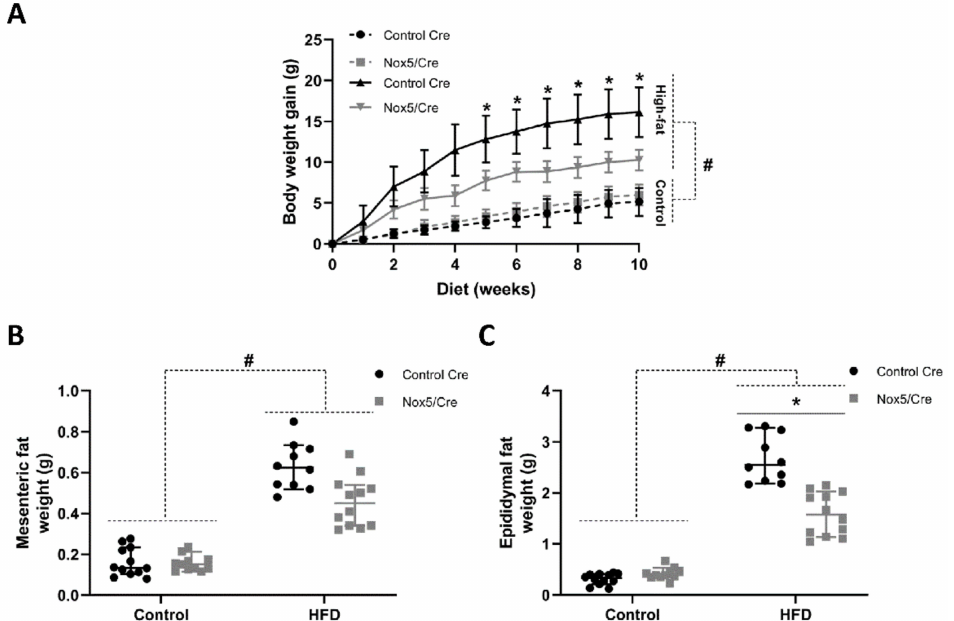
Figure 1. Endothelial NOX5expression reduced total body weight gain and the amounts of mesenteric and epididymal adipose tissues in mice fed a HFD for 10 weeks. ( A ) Body weight gain. ( B ) Mesenteric fat weight. ( C ) Epididymal fat weight. Control diet: control Cre ( n = 12), Nox5/Cre ( n = 11); high-fat diet: control Cre ( n = 10), Nox5/Cre ( n = 12). Values are expressed as median with confidence interval. # p < 0.05: diet differences (dotted lines); * p < 0.05: genotype differences (solid lines). Statistical tests used: Aligned Rank